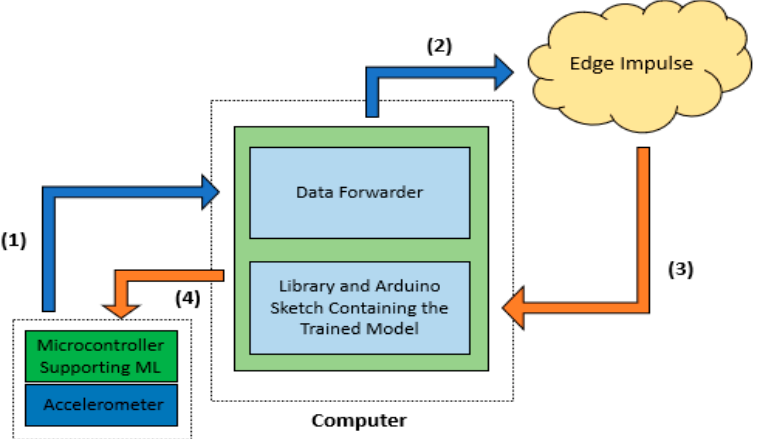
Figure 4. The necessary sequence of steps to be followed for the machine learning training and deployment processes: sensor data acquisition (1), data preparation (2), model design and creation (3), optimized model deployment onto the in-situ microcontroller (4).